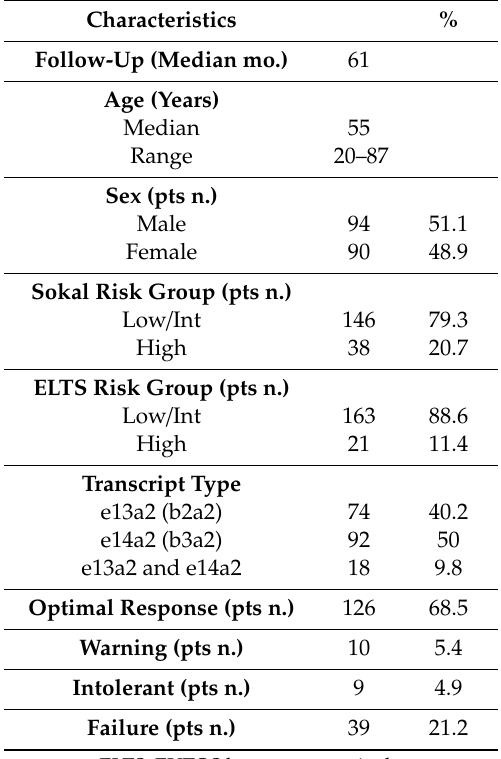
Table 1. Patient characteristics ( n =